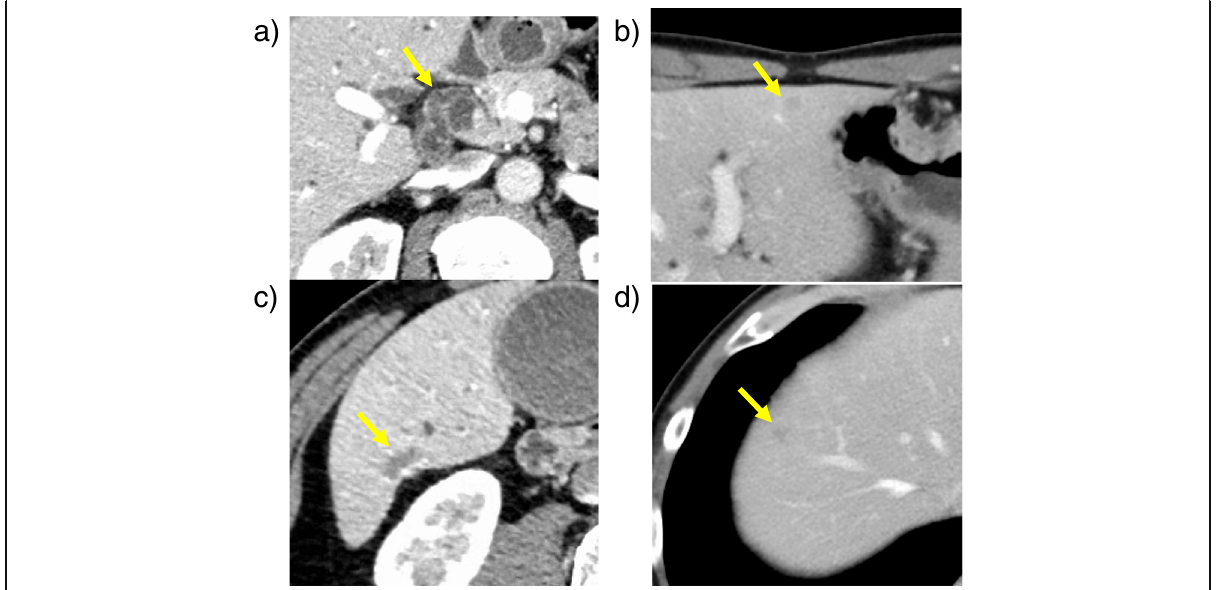
Fig. 1 Multiple intrahepatic and extrahepatic bile duct cancers shown by dynamic abdominal computed tomography. a Thickening of the distal bile duct wall with upstream biliary dilatation (arrow). Multiple low-density tumors with peripheral enhancement in b segment III, c segment VI, and d segment VIII in the liver